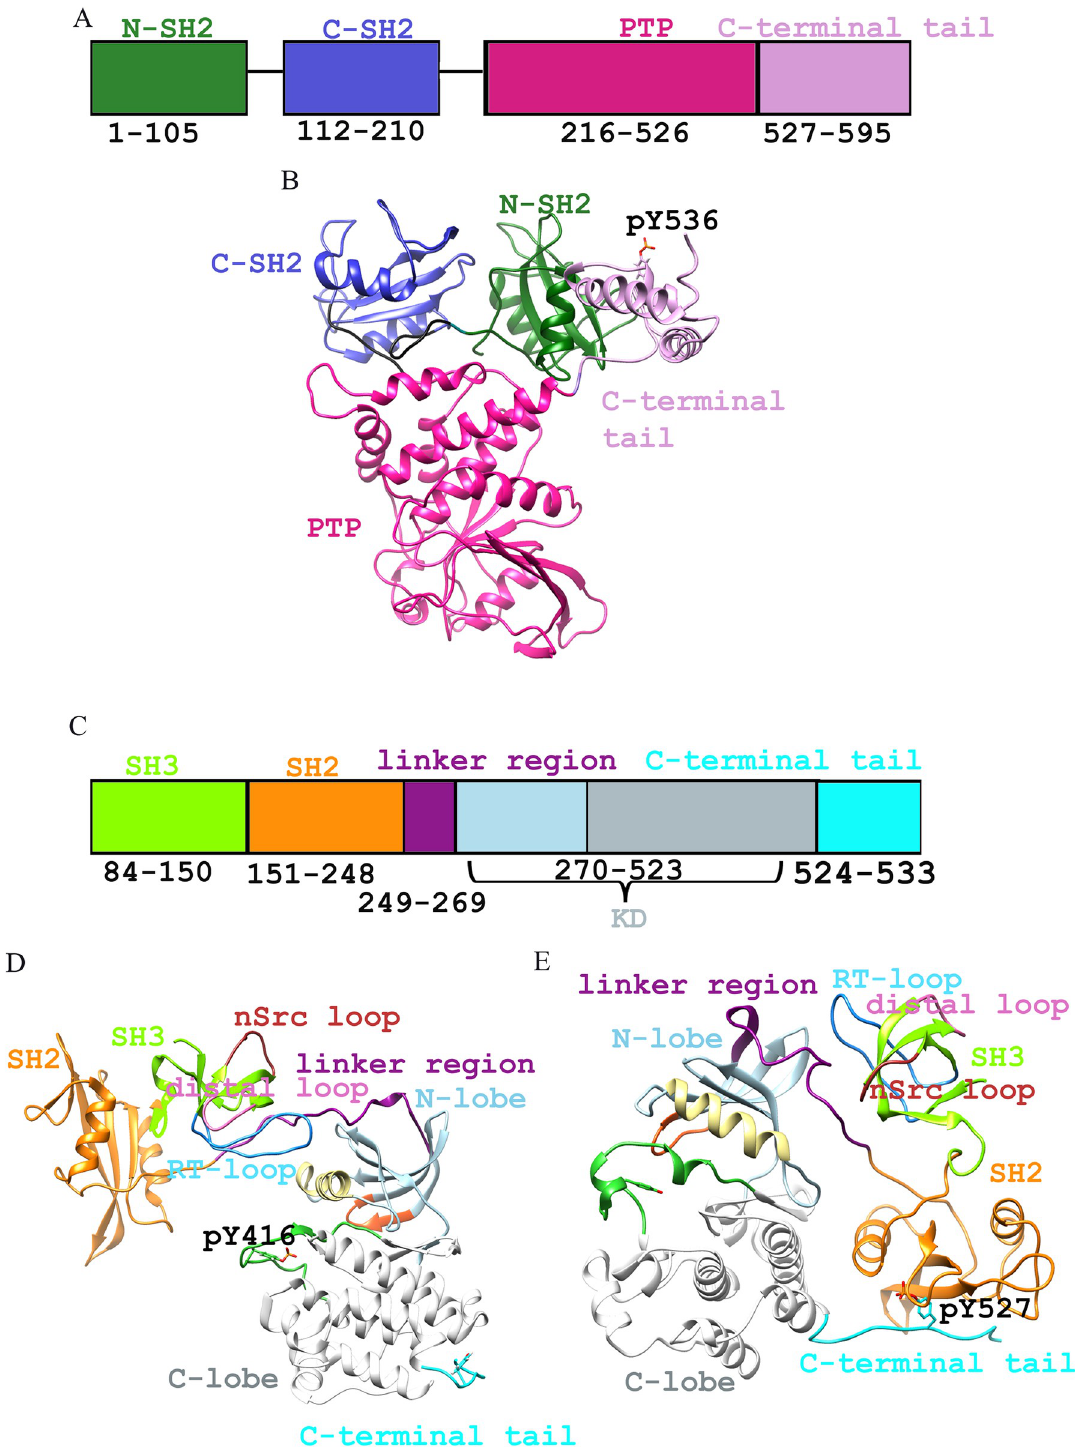
Fig 1. 3D structures of SHP-1, c-Src open, and c-Src close . (A) Schematic and (B) 3D structure representation of SHP-1. (C) Schematic and (D and E) 3D representation of c-Src open and close conformation. SHP-1: At the N-terminus, two tandems of SHP-1 are shown in dark cyan (N-SH2) and deep blue (C-SH2) color, while PTP is in pink and C-terminal tail is indicated in plum color. Color codes for SH3, SH2 domain, and linker region are displayed in chartreuse, orange, and dark magenta colors, respectively. Kinase domain, N-lobe, C-lobe, and A-loop are shown in light blue, white, and lime green colors, respectively. Gly-loop and C-terminal tail are shown in orange-red and cyan colors, while phosphorylated residues (pY416 and pY527) are shown in the deep pink sphere, respectively. https://doi.org/10.1371/journal.pone.0278448.g001 PLOS ONE | https://doi.org/10.1371/journal.pone.0278448 January 13,